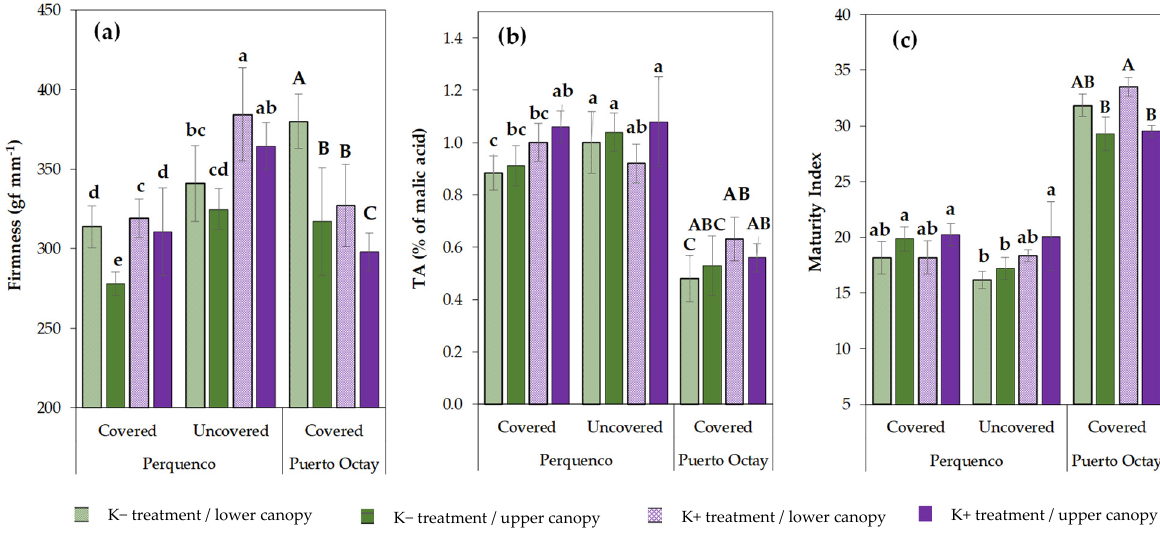
Figure 1. Firmness ( a ), titratable acidity ( b ), and maturity index ( c ) at harvest of sweet cherry fruits (cultivar Regina) harvested from trees cultivated in two commercial orchards of southern Chile (Perquenco and Puerto Octay, during the 2019/2020 season. In each location, trees were subjected to two foliar potassium (K) treatments: conventional K regime (4 sprays during the season: K − treatment) or intensive K regime (7 sprays during the season; K+ treatment). In Perquenco orchard, covered and un-covered trees were compared. Fruits harvested from the lower or the upper area of the canopy were evaluated separately. Different lowercase and uppercase letters above the error bars (standard deviation) indicate significant differences between the treatments in the Perquenco and Puerto Octay orchards, respectively, according to LSD Fisher multiple range test ( p ≤ 0.05).